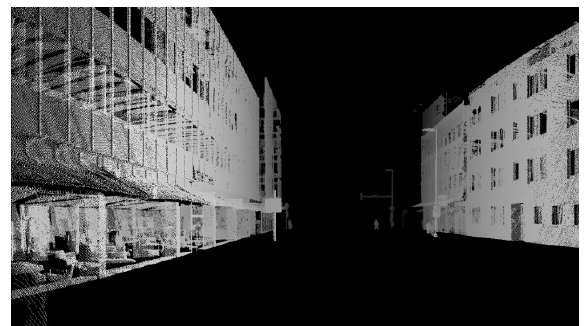
Figure 1. Generated range image